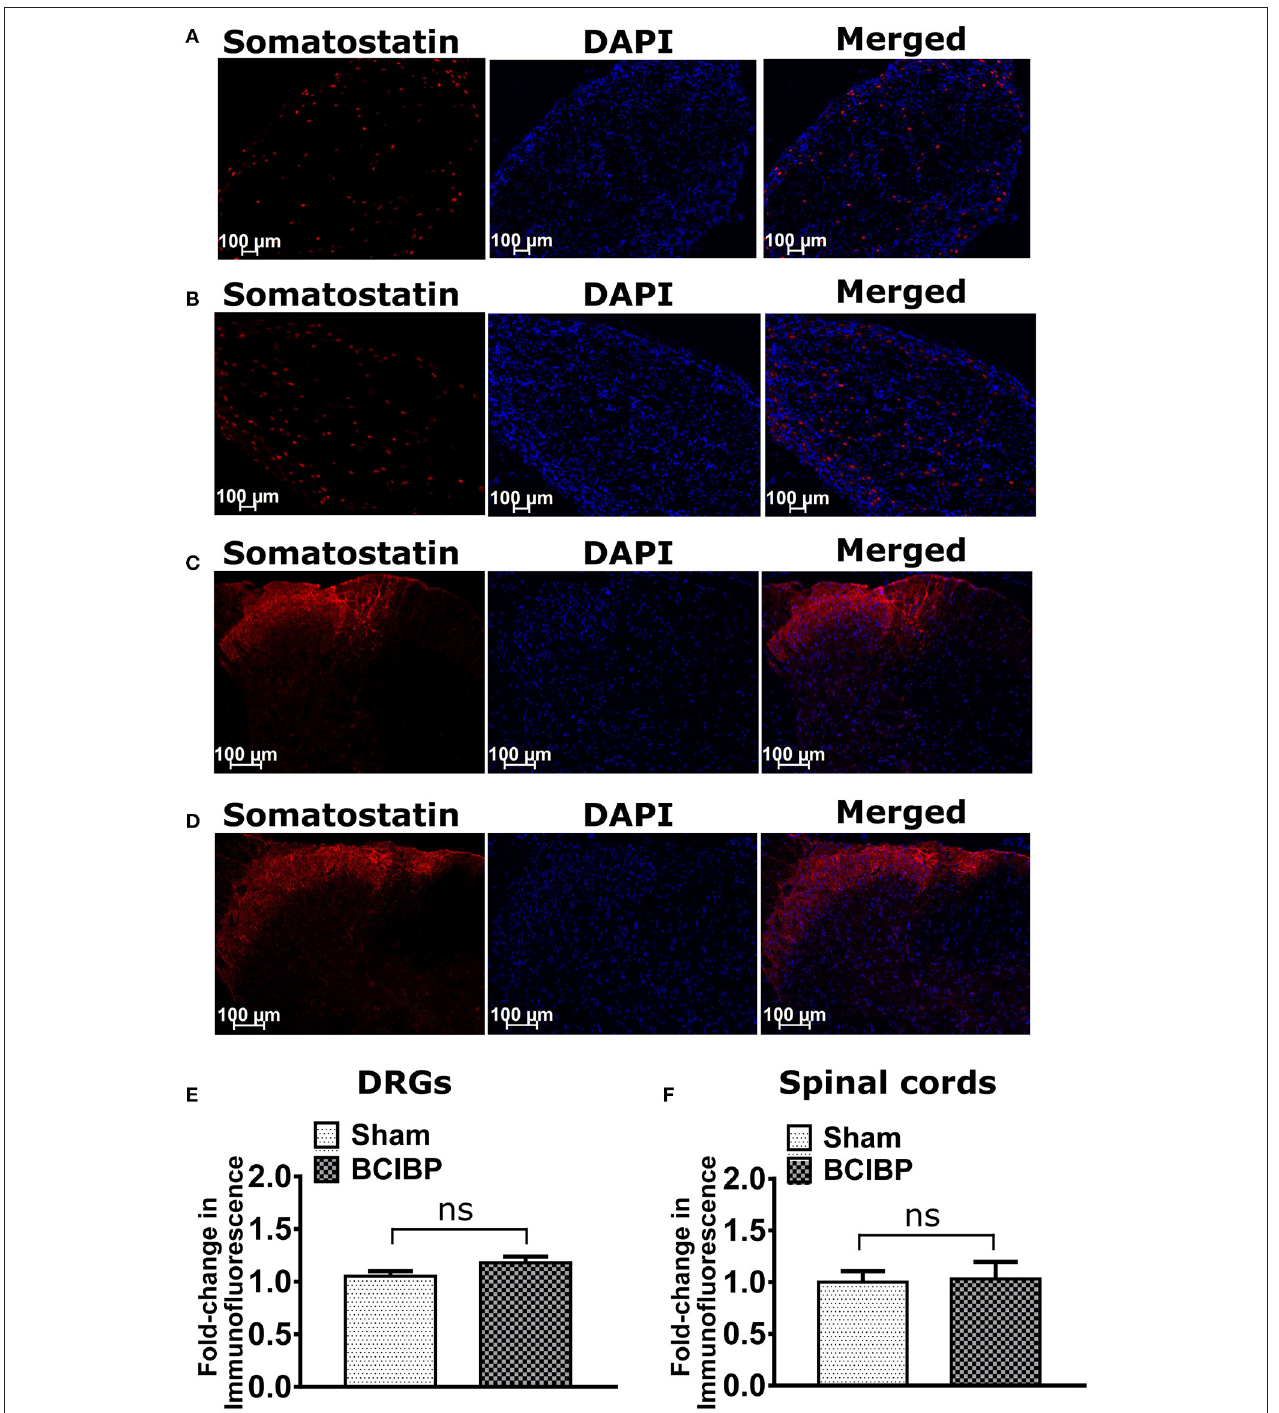
FIGURE 6 | Expression levels of somatostatin in sections of ipsilateral lumbar L4-L6 dorsal root ganglia (DRGs) and spinal dorsal horns of BCIBP-rats and the corresponding sections from sham rats ( n = 3–4/group). Panels in the figure show representative sections of (A) a lumbar DRG from a sham rat, (B) a lumbar DRG from a BCIBP-rat, (C) a lumbar spinal dorsal horn from a sham rat and (D) a lumbar spinal dorsal horn from a BCIBP-rat. (E) shows fold-change in immunofluorescence of DRG sections from the BCIBP group relative to the corresponding sections from the sham group and (F) shows the fold-change in immunofluorescence of lumbar spinal cord sections from the BCIBP group relative to the sham group. ns, statistically not significant ( p > 0.05, Mann-Whitney test).